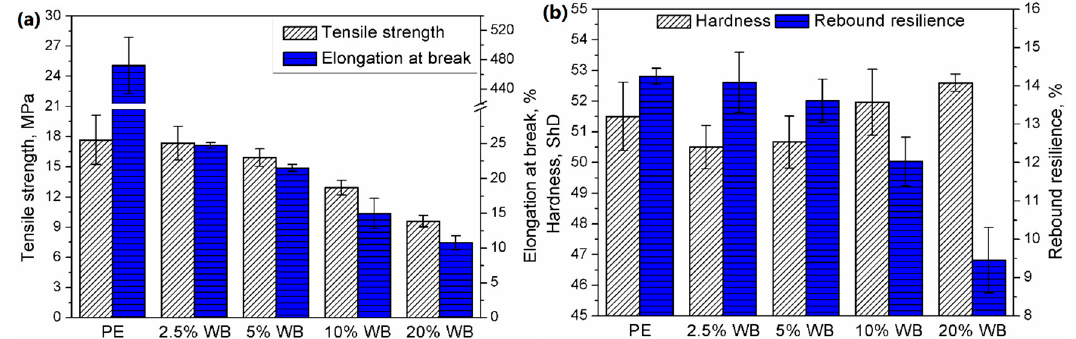
Figure 9. Mechanical properties: ( a ) tensile strength and elongation at break, and ( b ) hardness and rebound resilience of rotationally molded PE and PE-WB composites.